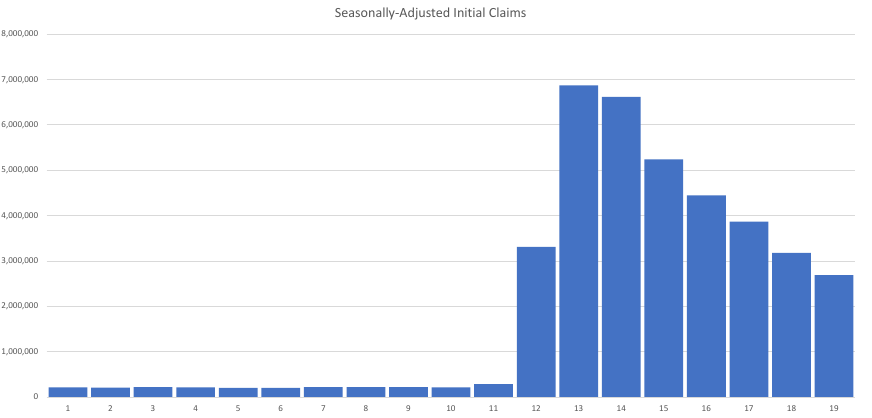
Figure 3. As of 1 June 2020, the U.S. had 40 million unemployed. Job losses over the past 8 weeks erased all jobs created over the past decade. Source: The United States Department of Labor.